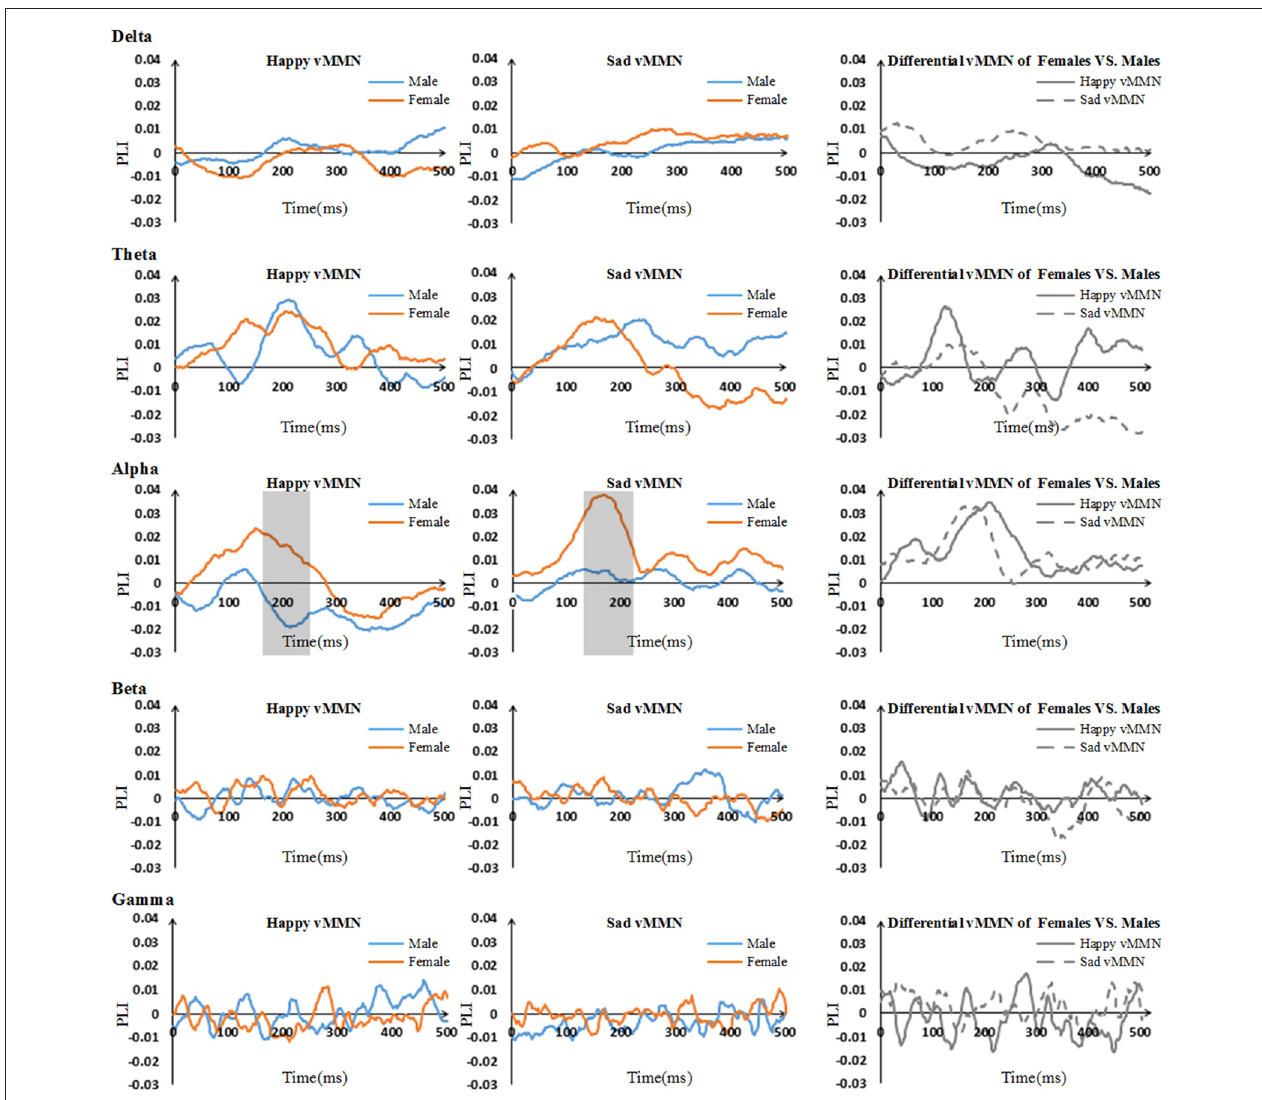
FIGURE 3 | Time courses of the average phase lag index (PLI) values and differential PLI between males and females regarding the vMMN for all participants in the five bands (including 500 ms after stimulus onset). The gray areas are the time windows in which there was a significant difference between males and